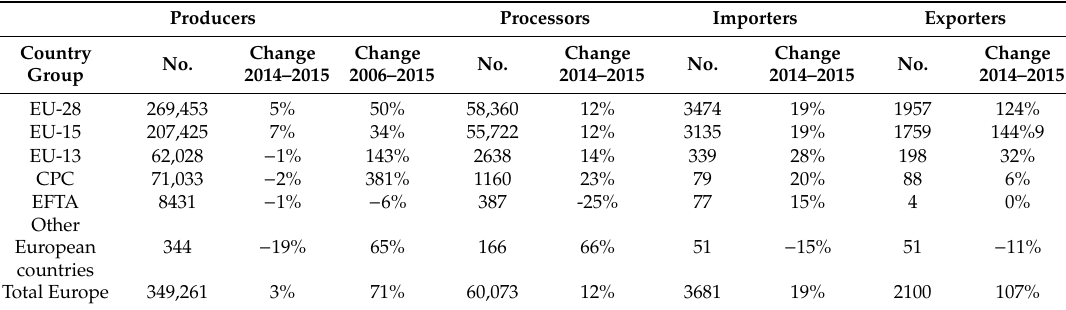
Table 3. Organic operators by country.